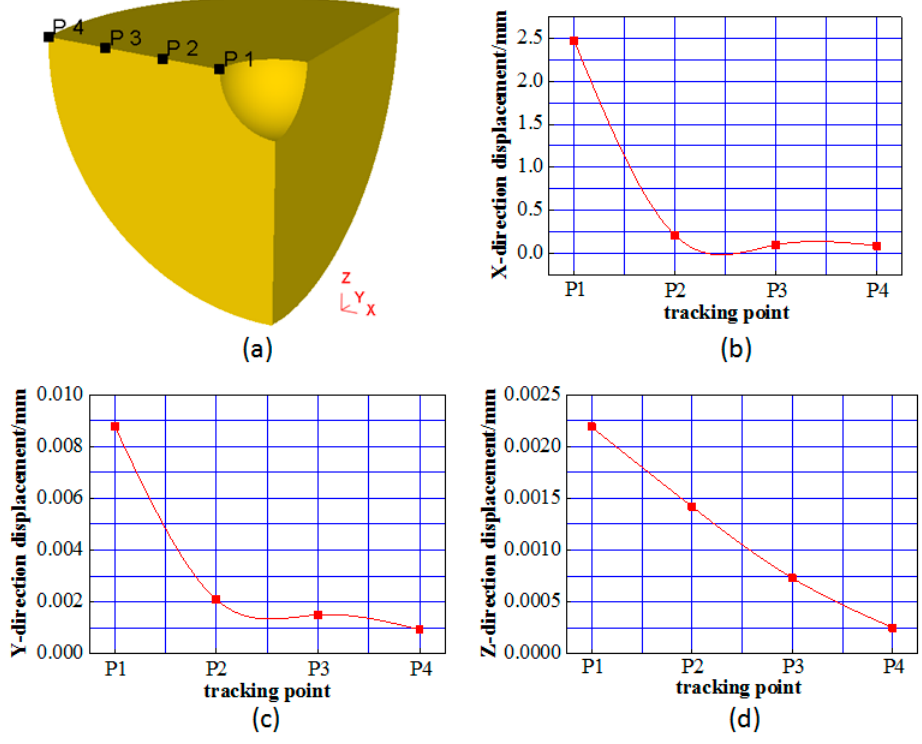
Figure 8. The flow law of void in steel ball. ( a ) Four tracking points on the model; ( b ) X-directional displacement of the tracking points; ( c ) Y-directional displacement of the tracking points; ( d ) Z-directional displacement of the tracking